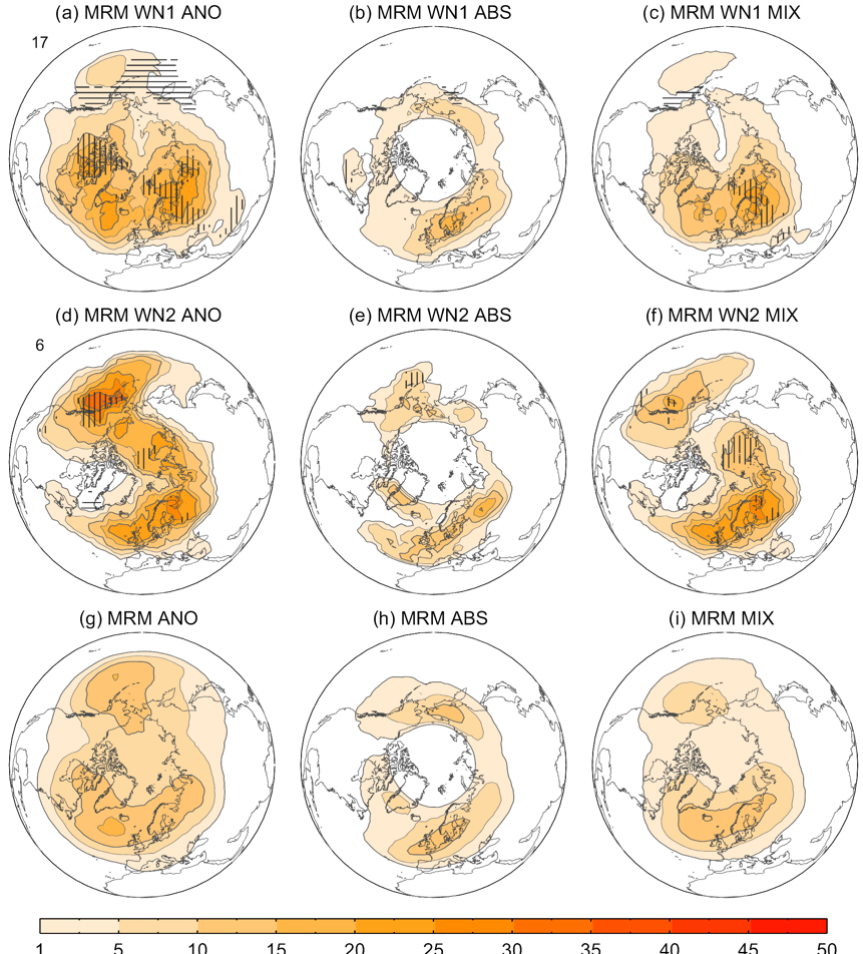
Figure 8. (a–c) MRM of blocking frequency (% of winter days) for the [ − 10, 0]d period before the central date of WN1 SSWs of the comparison period (1979–2012) for the (a) anomaly (ANO), (b) absolute (ABS), and (c) mixed (MIX) methods. The blocking frequency is expressed as the percentage of time (over the 11d period) during which a blocking was detected at each grid point. Vertical (horizontal) hatching denotes regions where at least 66.7% of the reanalyses show a significant increase (decrease) of the frequency with respect to the climatology at the 90% confidence level. (d–f) Same as (a) – (c) but for WN2 SSWs. (g–i) MRM of the mean blocking frequency in 1000 Monte Carlo trials of 11d intervals preceding all SSWs dates of the comparison period. In each trial, a set of 11d intervals prior to the SSWs dates of random years is averaged so that we obtain a pseudo-climatology of the blocking frequency in the same winter moments as when the SSWs took place. This method avoids any effects of the seasonal cycle of the blocking activity during the extended winter (NDJFM) that would affect the result if we averaged directly the blocking activity during that